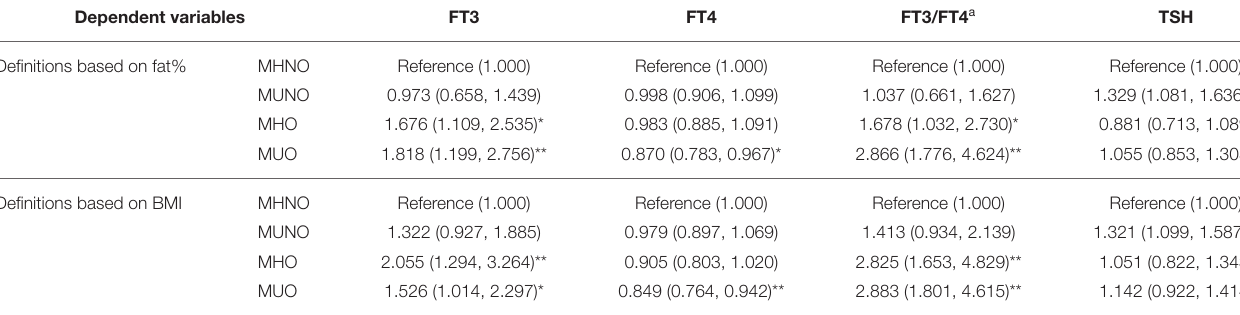
TABLE 2 | Multivariate logistics regression